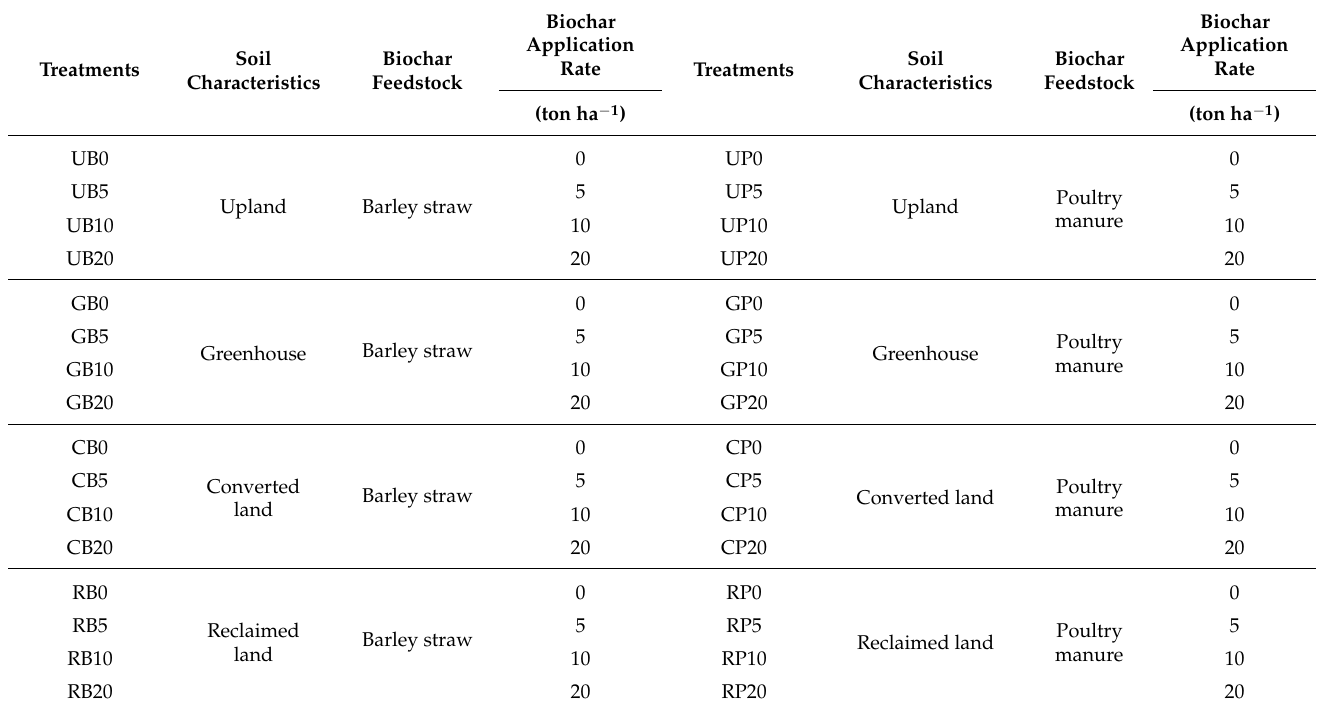
Table 3. Description of the experimental